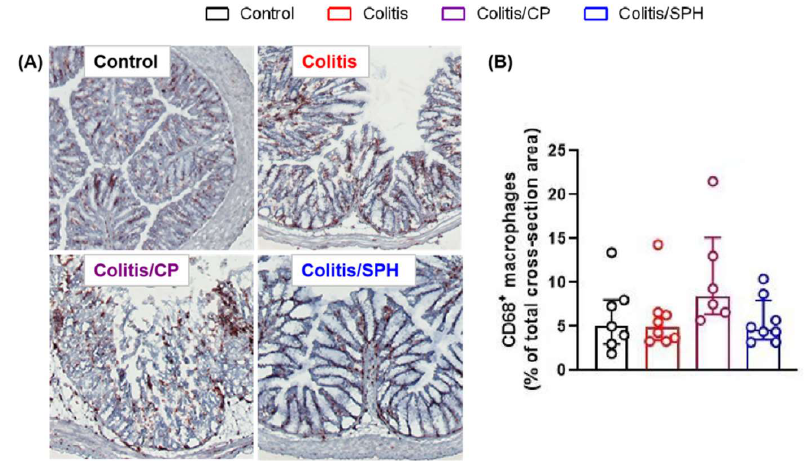
Figure 5. The infiltration of macrophages in colon tissues under different interventions. ( A ) IHC images (×200) and ( B ) percentage of CD68-positive stained areas in total colonic cross-section area. The numbers of mice were 7, 8, 8, and 8 in each individual groups. Data are presented as median and interquartiles (Q1:Q3) and analyzed by Kruskal–Wallis test. Note that there was no statistically significant difference in the CD68 + expression of macrophages among four groups ( p > 0.05).